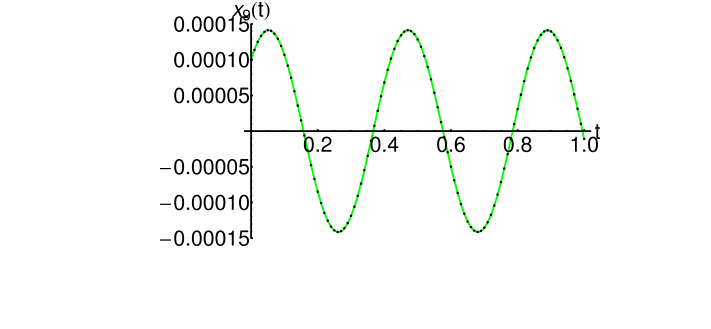
Fig. 9. Comparison between the approximate solutions ¯ x 9 given by Eq. (36) and the corresponding numerical